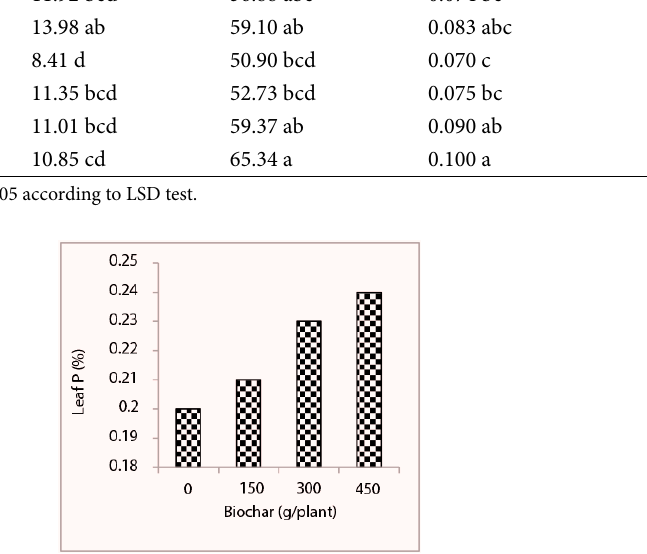
Figure 3 The effects of biochar levels on P content of melon leaf. Mean values withthe same letters are not significantly different at p ≤ 0.05 according to LSD test.